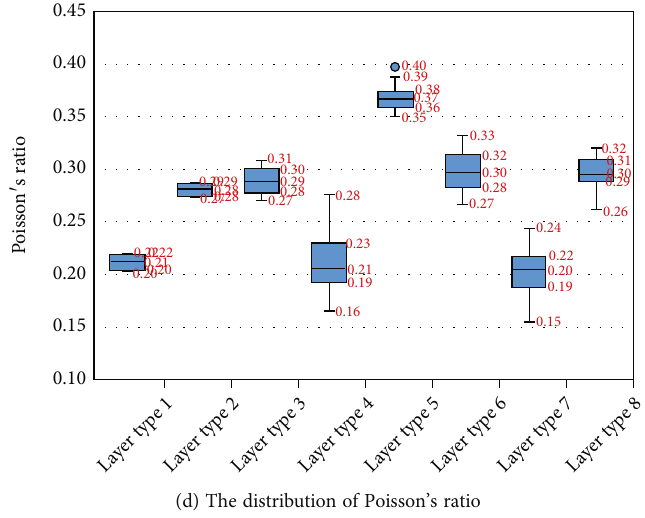
(d) The distribution of Poisson ’ s ratio Figure 2: The distribution of the geological data of di ff erent layer types.